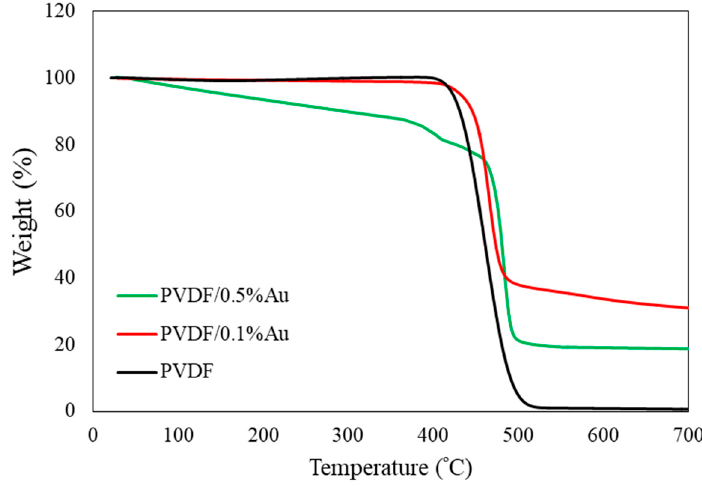
/ Au nanocomposites